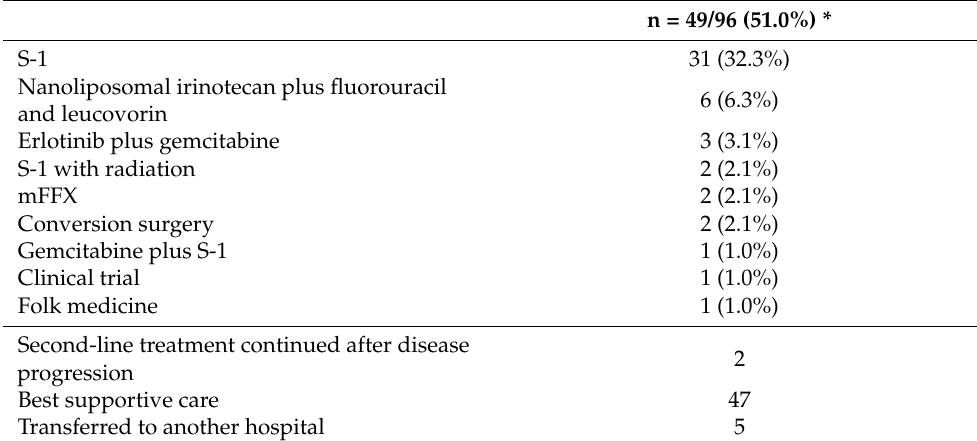
Table 6. Subsequent treatment after second-line gemcitabine plus